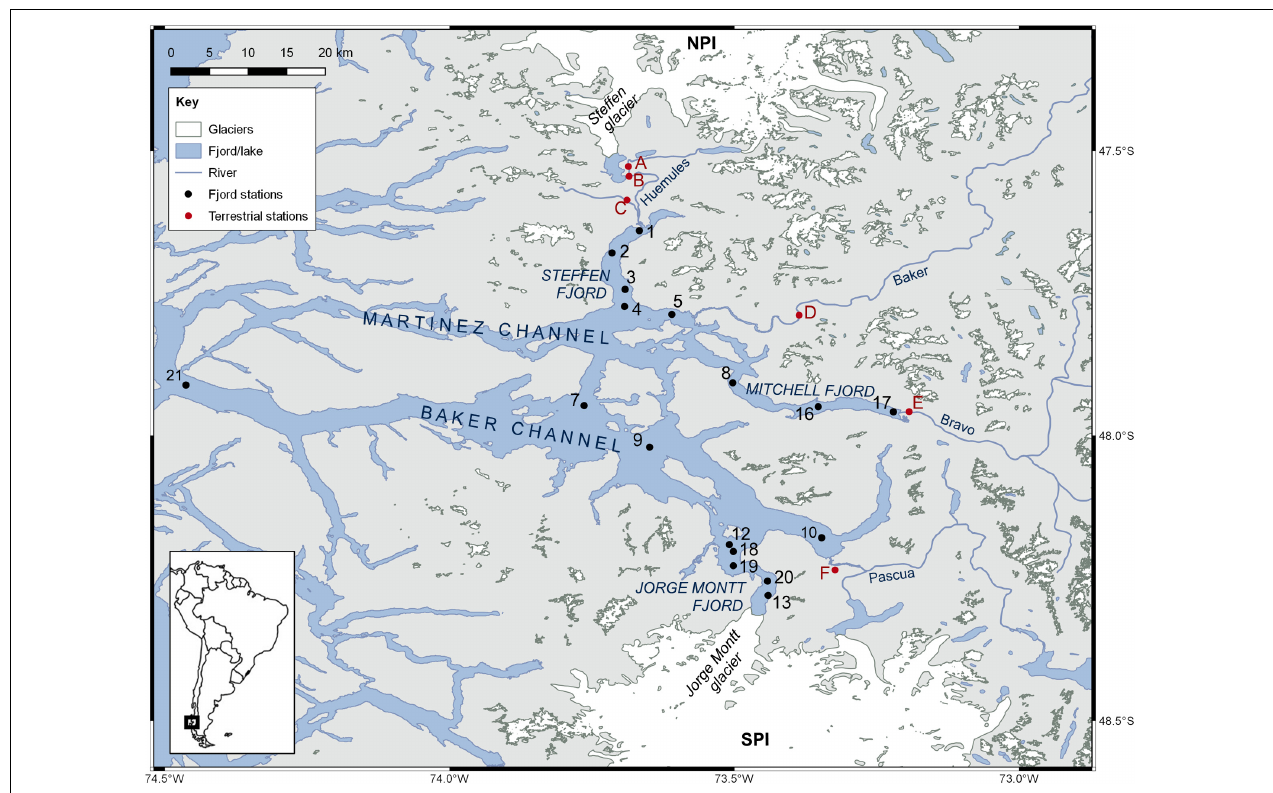
FIGURE 1 | Location of sampling stations (1–21) in Baker-Martinez Fjord and on the tributary rivers